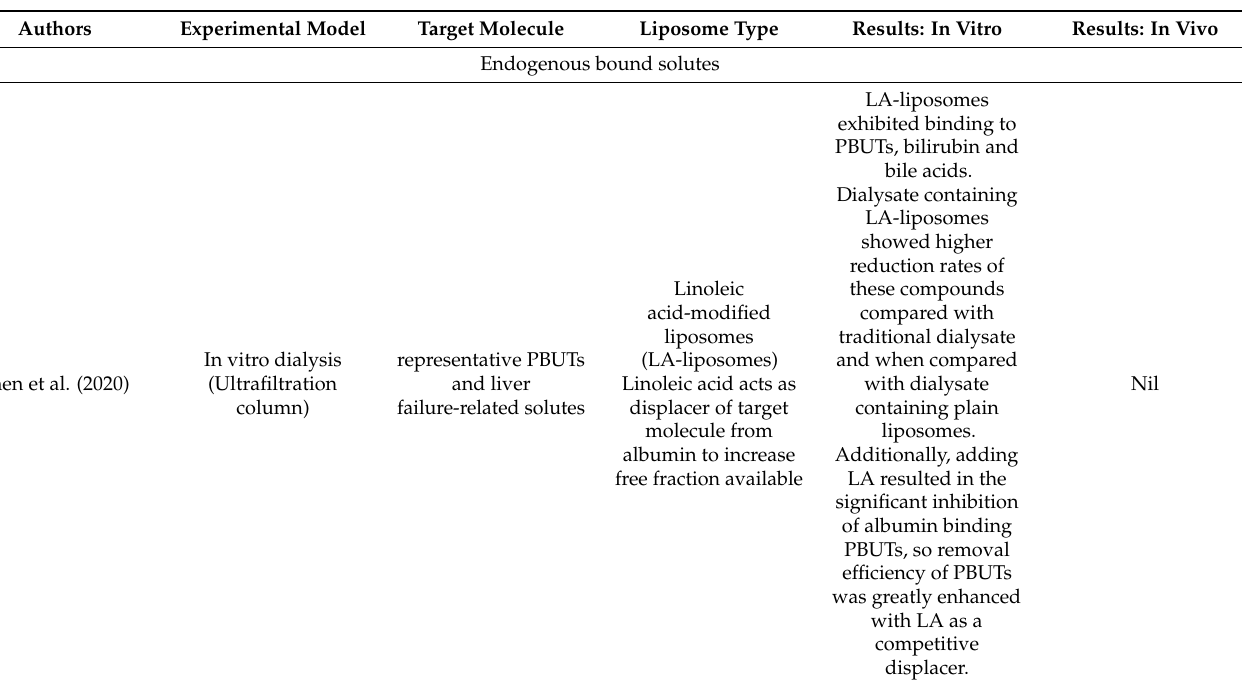
Table abbreviations: CARPA—complement activation-related pseudoallergy; DOPG—1,2-dioleoyl- sn -glycero-3-phosphoglycerol; DPPC— dipalmitoylphosphatidylcholine; HA—hippuric acid; ILE—intravenous lipid emulsion; IS—indoxyl sulphate; IV intravenous; LA—linoleic acid; LSPD—liposome-supported peritoneal dialysis; PBUT—protein-bound uraemic toxin; PCS—p-cresyl sulphate; SP—soy phospholipid. † indicates a positive in vitro finding which translated into a positive in vivo